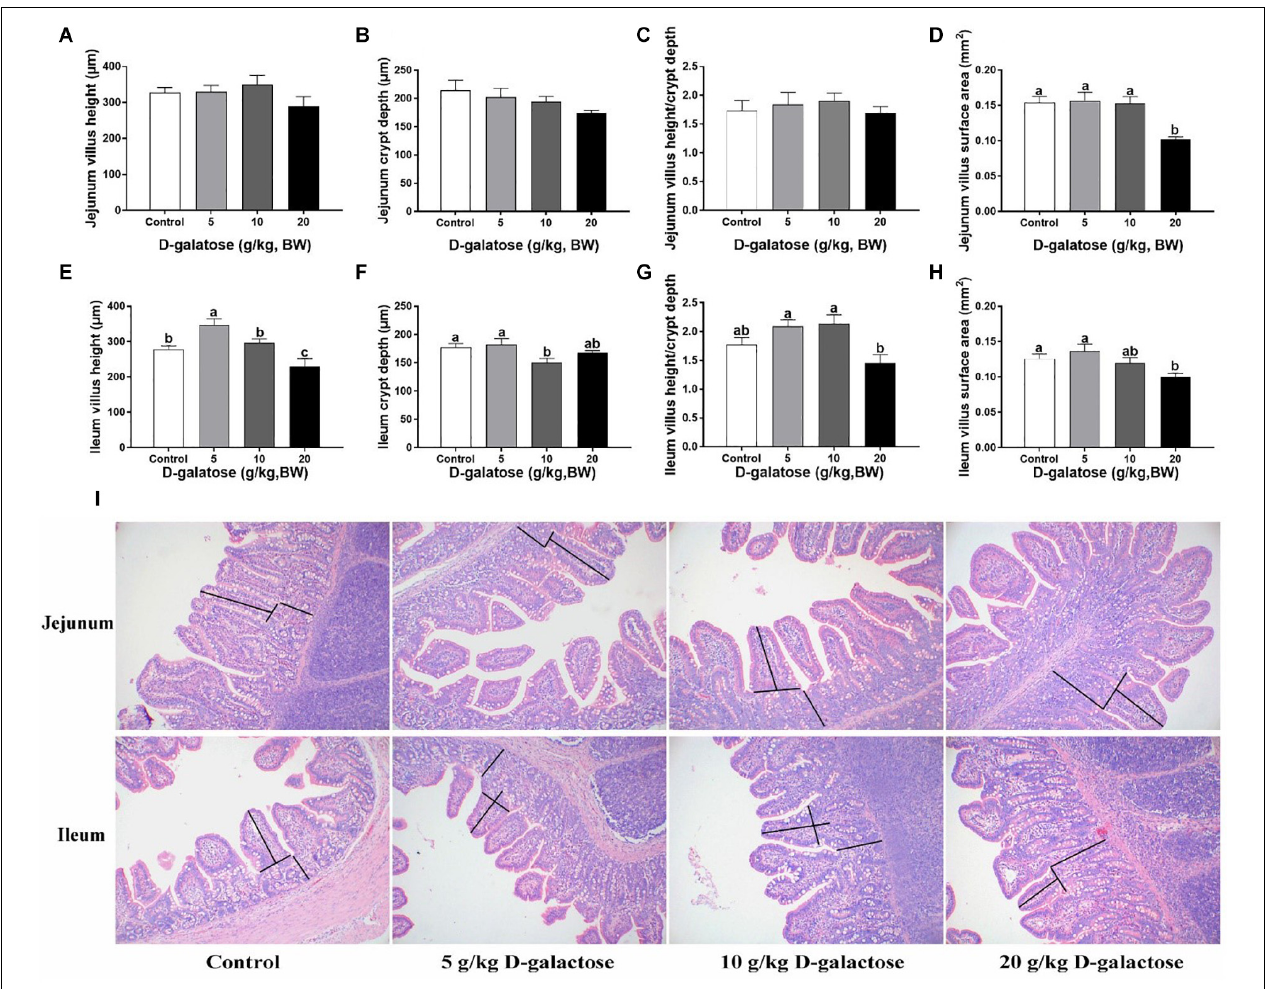
FIGURE 2 | Effects of D -galactose on jejunal and ileal morphology. (A) Jejunum villus height; (B) Jejunum crypt depth; (C) Jejunum villus height/crypt depth; (D) Jejunum villus surface area; (E) Ileum villus height; (F) Ileum crypt depth; (G) Ileum villlus height/crypt depth; (H) Ileum villus surface area; (I) Representative images of HE staining in the jejunum and ileum. Data were expressed as the mean ± SEM. Different lower-case letters indicate a significant difference among different dosage of D -galactose ( P < 0.05).